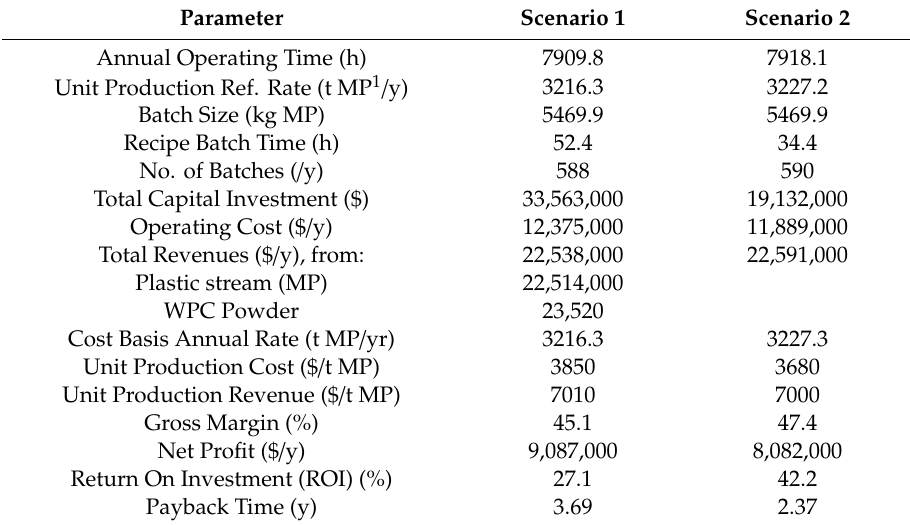
Table 2. Results of economic